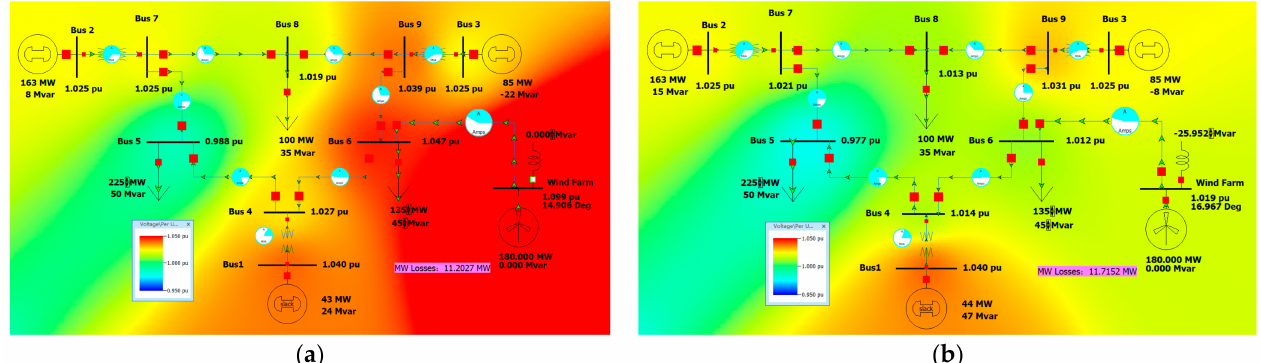
Figure 9. Simulation results when tower C is connected to bus 6 (300 km) after adding inductance. ( a ) The results under the maximum load condition and ( b ) the results under the maximum load condition with reactor.